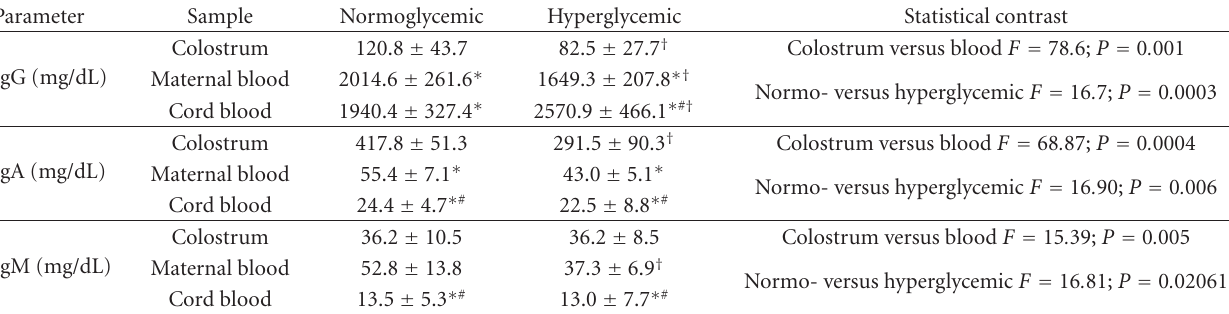
Table 2: Mean ( ± SD) immunoglobulin level in colostrum, maternal blood, and cord blood from normoglycemic and hyperglycemic women.